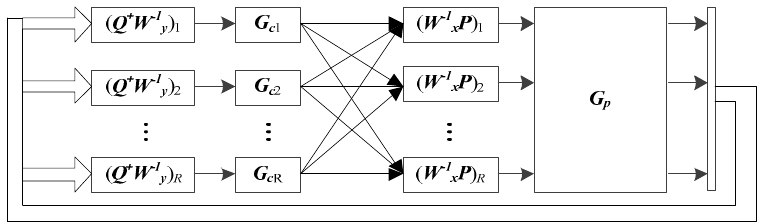
Figure 3. The structure of proposed method in distributed form.